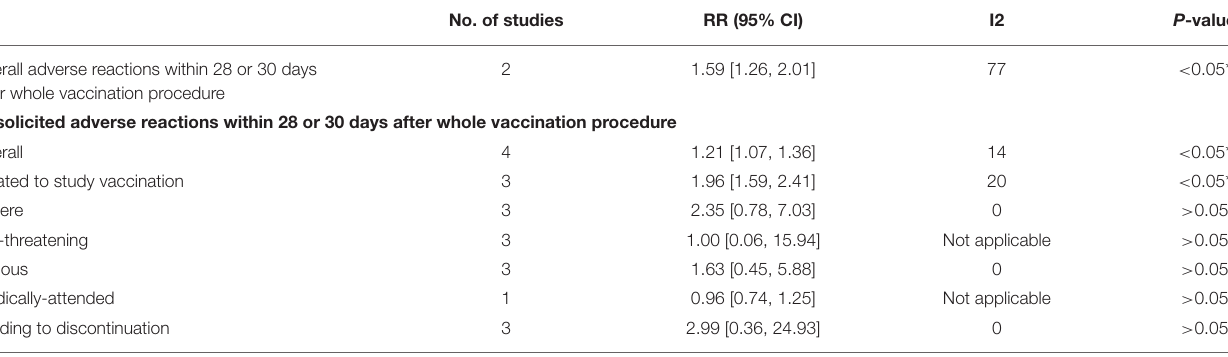
TABLE 2 | Overall adverse reactions and unsolicited adverse reactions within 28 or 30 days after whole vaccination procedure in inactivated vaccine group vs. control group.